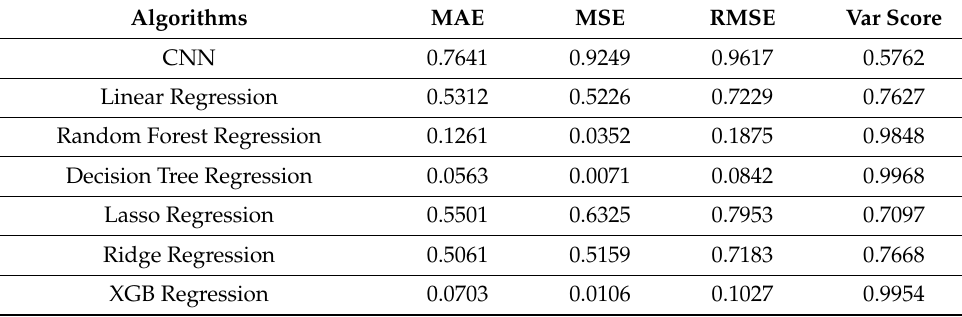
Table 5. The resonant frequency prediction performance of ML